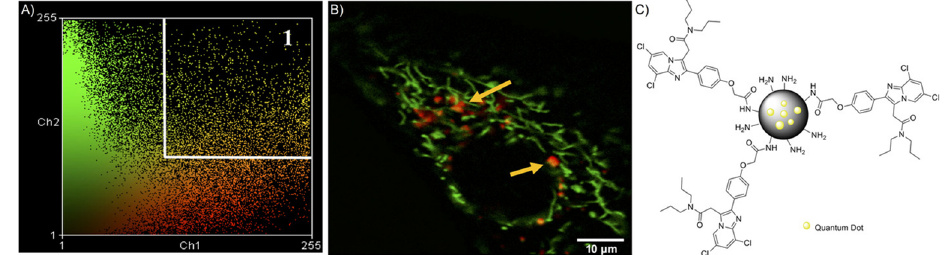
Figure 8. ( A ) Co-localization analysis of C6 rat glioma cells stained with MitoTracker green and TSPO-targeted QD@SiO 2 NPs. All pixels of the co-localization image shown in panel B are reported in the scatter diagram of panel A, in which the two image channels are compared. Region 1 of the diagram displays the co-localization pixels. ( B ) Representative confocal image of co-localization of TSPO-targeted QD@SiO2 NPs (red) and MitoTracker (green) in C6 cells. The co-localization is marked by the convergence of the red and green to yellow fluorescence; scale bar: 10 µ m. ( C ) TSPO-targeted QD@SiO 2 NPs. Reproduced with permission [62]. Copyright 2017, Wiley-VCH Verlag GmbH & Co. KGaA, Weinheim.